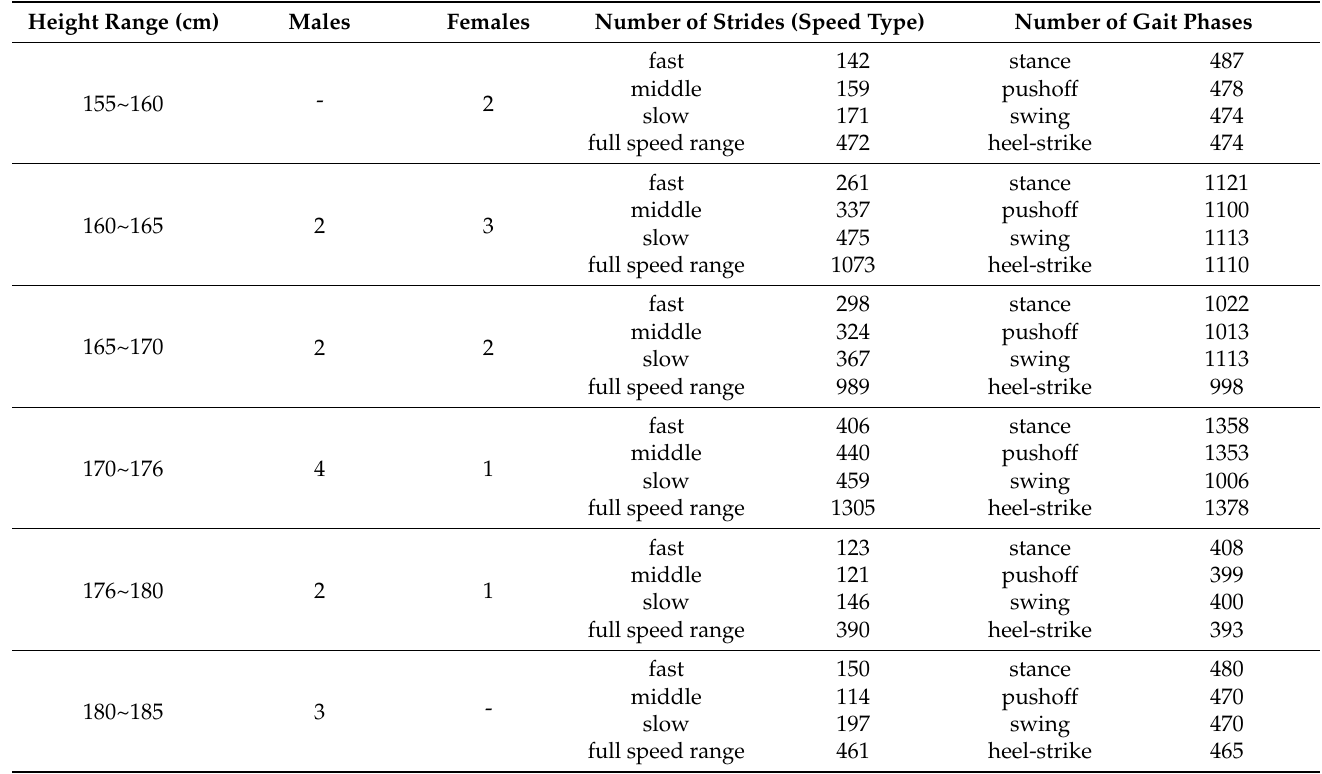
Table 1. A total of 22 healthy volunteers (13 males, 9 females, age 32.5 ± 7.5 years) participated in the study and were divided into different groups according to gender and height